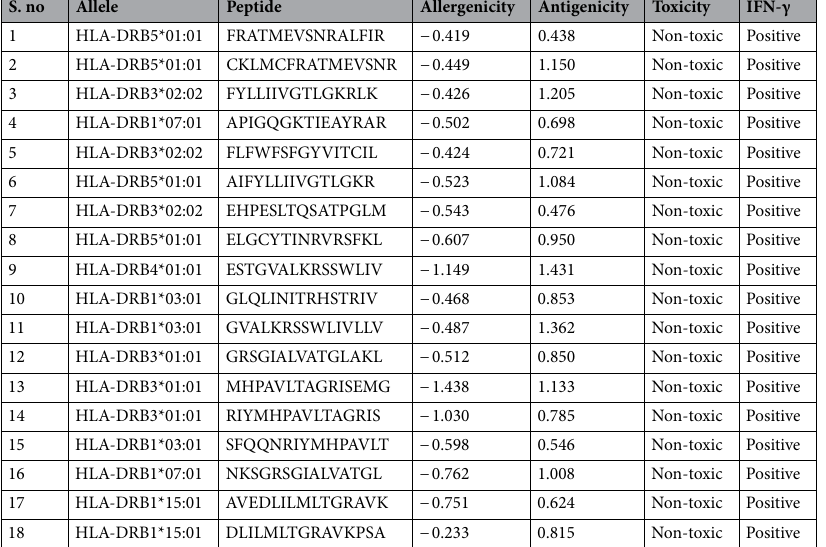
Table 3. Selected helper T lymphocyte (CTL) epitopes for multi-epitope vaccine construction. IFN-γ